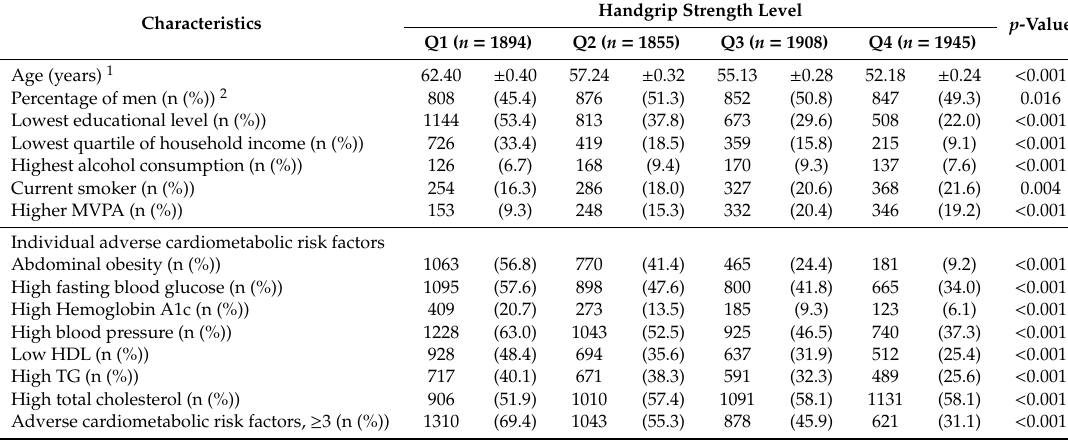
Table 2. Characteristics of study population by category of handgrip